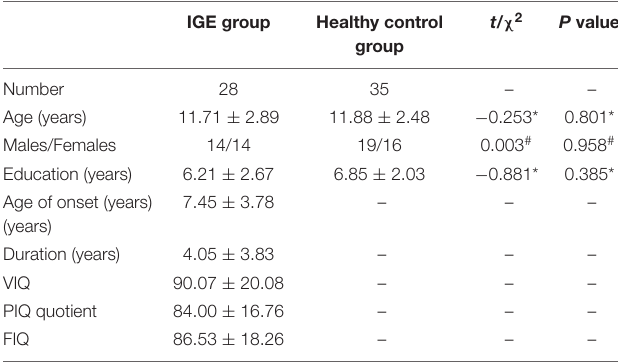
TABLE 1 | Demographic and clinical